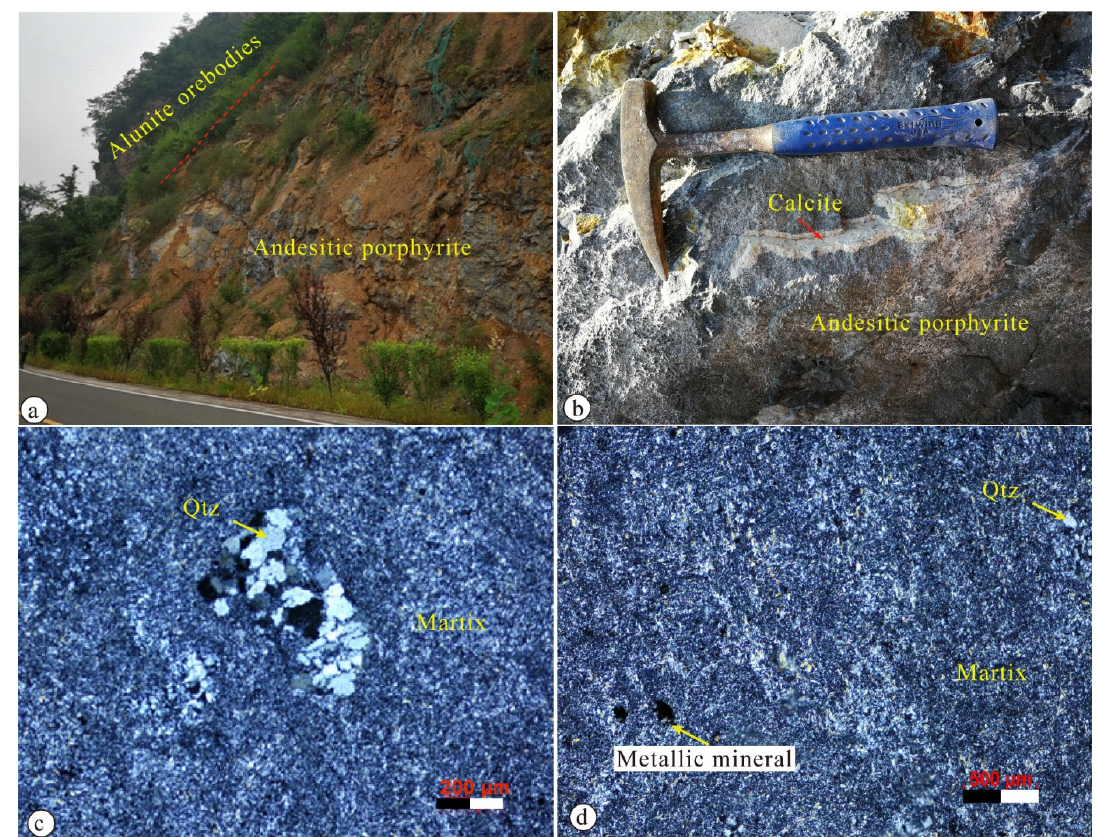
Figure 3. Field ( a,b ) and microscope photographs ( c,d ) for the Saozhouhe andesitic porphyrite. Figure 3. Field ( a , b ) and microscope photographs ( c , d ) for the Saozhouhe andesitic